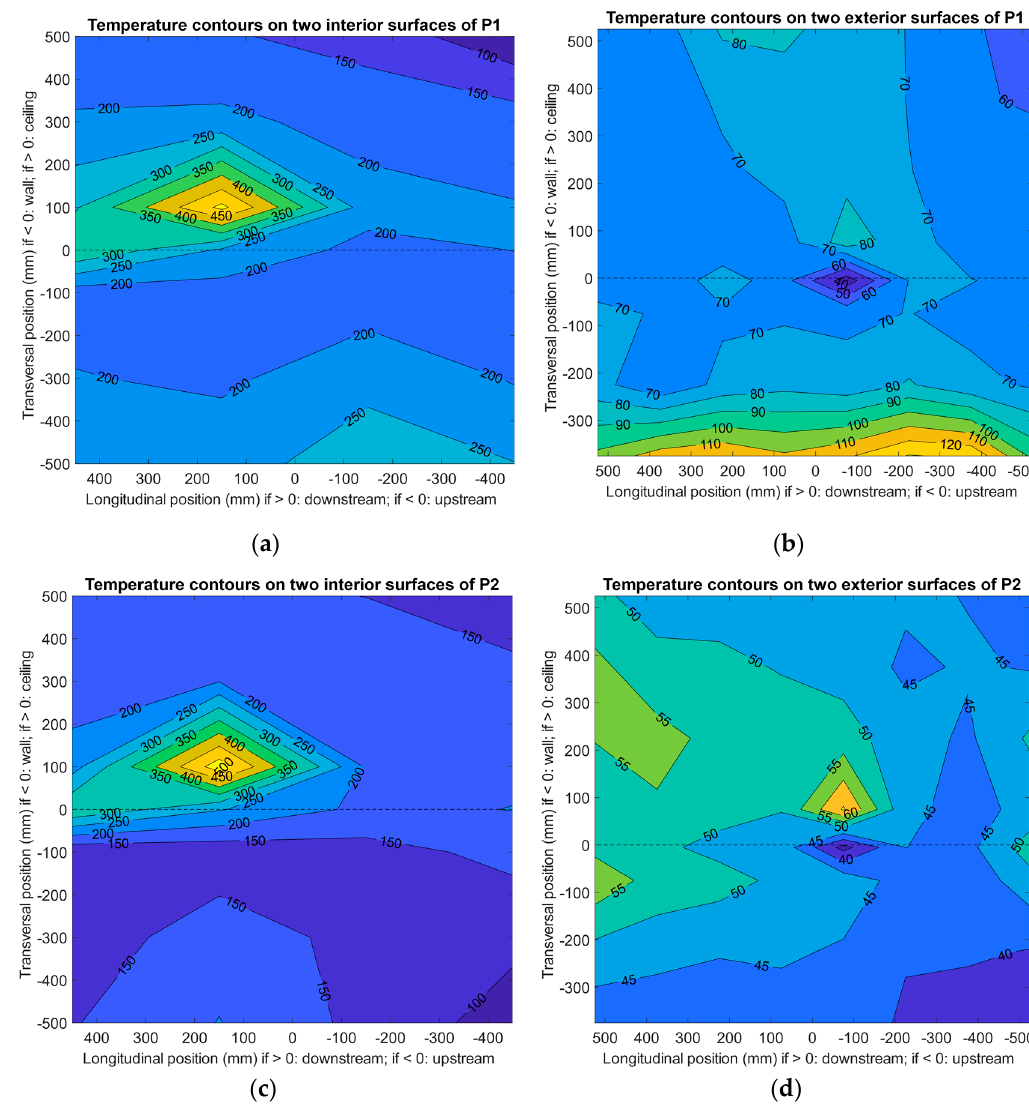
Figure 5. Effects of bare and covered angle irons on the thermal performance of Specimen 1 using a nozzle downstream after impinging for 30 min (data were interpolated by grid measurements): ( a ) case P1, interior surfaces; ( b ) case P1, exterior surfaces; ( c ) case P2, interior surfaces; and ( d ) case P2, exterior surfaces.